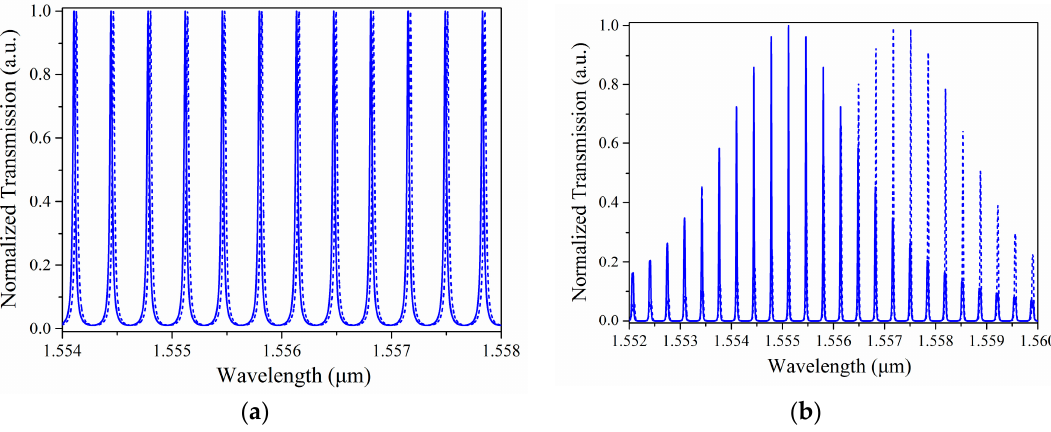
Figure 4. Wavelength shifts in the transmission spectra of ( a ) the individual sensing resonator, and ( b ) the cascaded resonators.